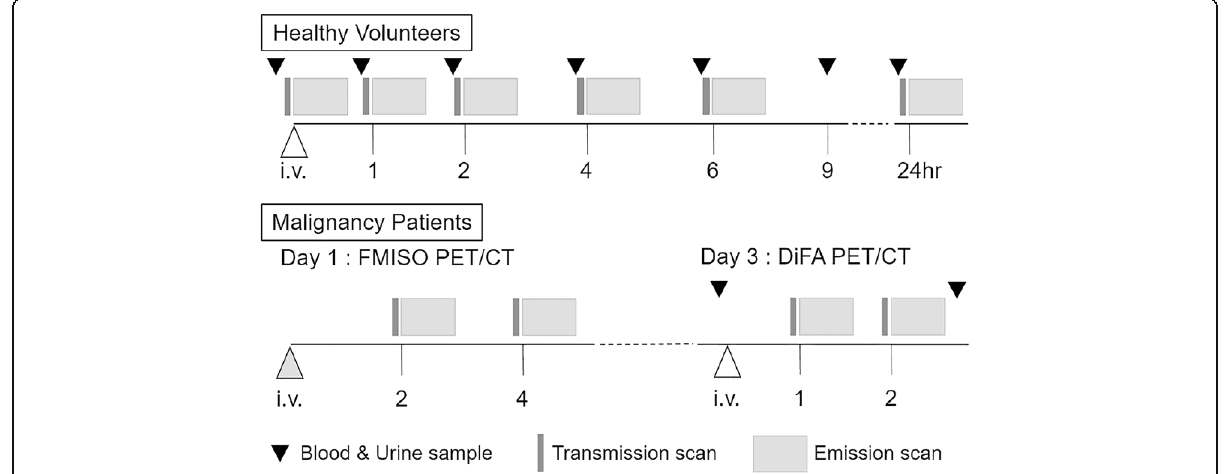
Fig. 2 The protocol of the dosimetry study of [ 18 F]DiFA (upper) and comparative study with [ 18 F]DiFA and [ 18 F]FMISO PET/CT